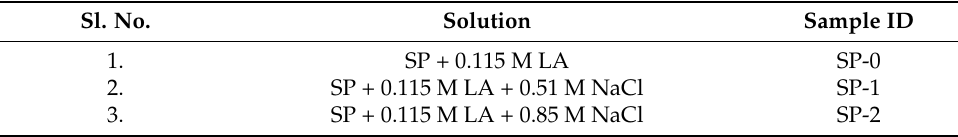
Table 2. Details of solution used in present